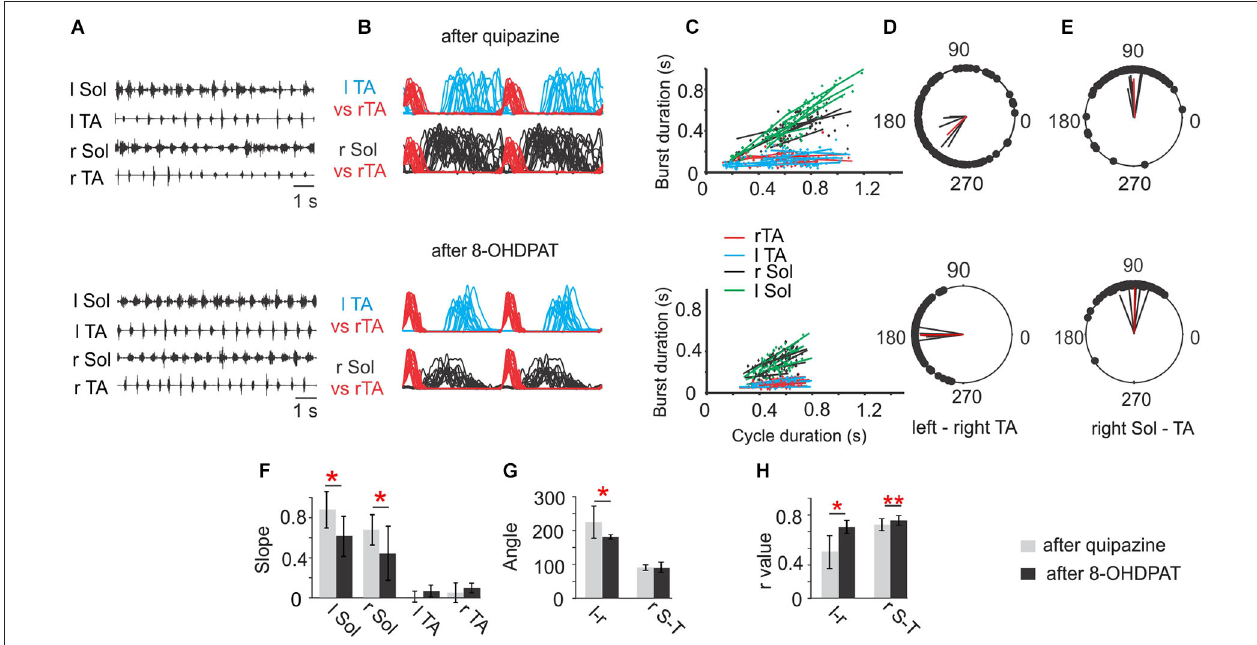
Sol—intralimb coordination ( E , lower and upper panels), the black lines each represent results of analysis established for one animal and the red line represents the average results across animals in the analyzed group. (F) Bar diagrams showing the mean slopes ( ± SD) for the regression lines between step cycle durations and burst durations for the left and right TA and Sol muscles in rats in locomotor hindlimb movement enhanced by either drug. (G) Bar diagrams showing the means ( ± SD) of the angle of the left–right TA (l–r) and of the right Sol–right TA (r S–T) relationships (relative timing of the onsets for the two muscles) represented in each polar plot in locomotor movements enhanced by application of quipazine and 8-OHDPAT in spinal rats. (H) Bar diagrams showing the means ( ± SD) of r -value between the times of onset of activity in both left-right and flexor-extensor EMG established for spinal rats treated either by quipazine or by 8-OHDPAT. Statistical significance by Student’s t -Test is indicated by red stars for ( n = 6) spinal rats tested during locomotor movement enhanced by either drug: * P < 0.05; ** P < 0.005. The details of the comparison between pre-drug and each agonist alone were presented in Figures 2, 6 and 7 of Sławi´nska et al.